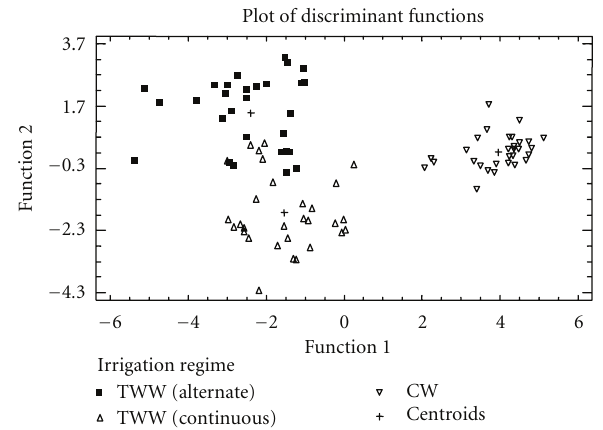
Figure 2: LDA plot for 90 olive oil samples (30 samples repeated three times) based on the concentration of 19 elements and using as input a priori three groups, that is, those corresponding to the irrigation regimes: alternate and continuous using TWW and